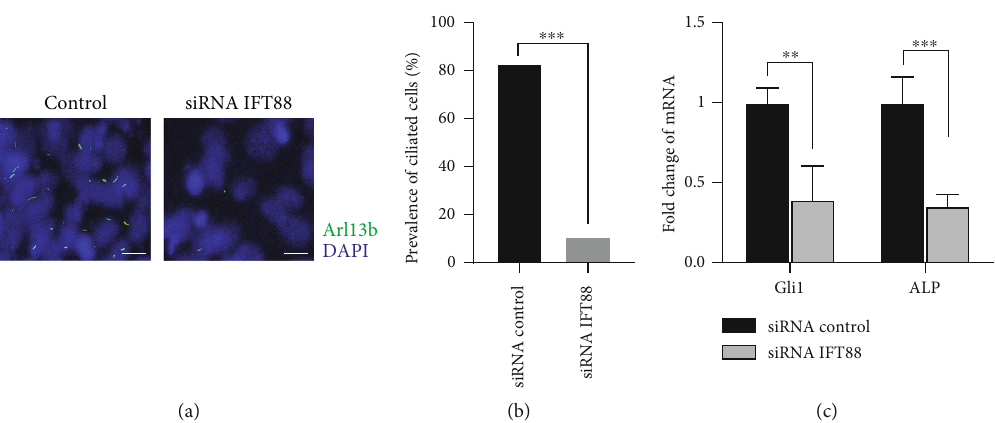
Figure 5: Depletion of primary cilia with a siRNA targeting IFT88 suppressed cilia formation and the gene expression of Gli1 and ALP. (a) Representative images showing the loss of primary cilia in P0 MSCs incubated with IFT88 siRNA. (b) The resultant decrease in ciliation was con fi rmed. (c) The gene transcriptional activities of Gli1 and ALP were compared, and it was found that loss of primary cilia suppressed hedgehog signaling and osteogenic di ff erentiation. ∗ p < 0 : 05 , Student ’ s t -test, versus MSCs treated with negative control